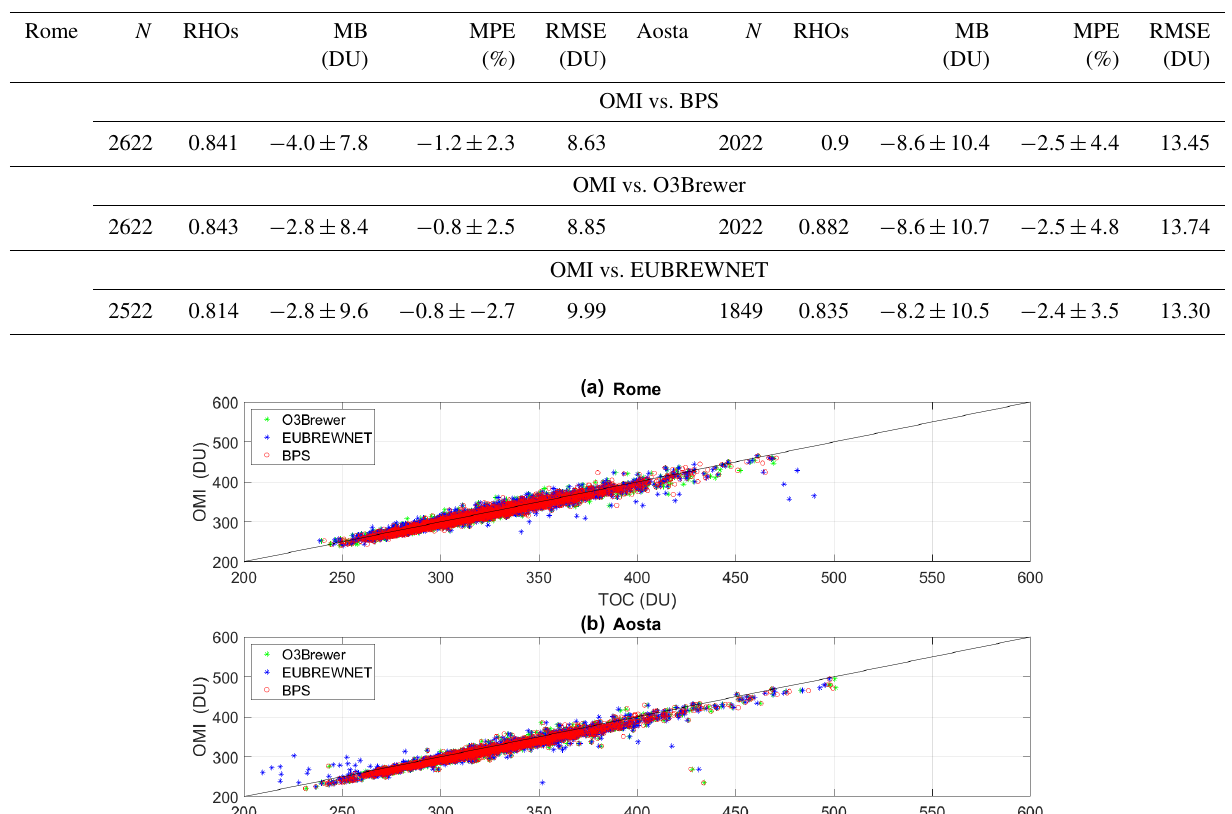
Table 5. Summary of the statistics of the comparison of OMI versus BPS, O3Brewer and EUBREWNET (N: number of data; RHOs: Spearman scaled correlation; MB: mean bias; MPE: mean percentage error; RMSE: root mean square error; the uncertainty of MB and MPE is characterized by the standard deviation).